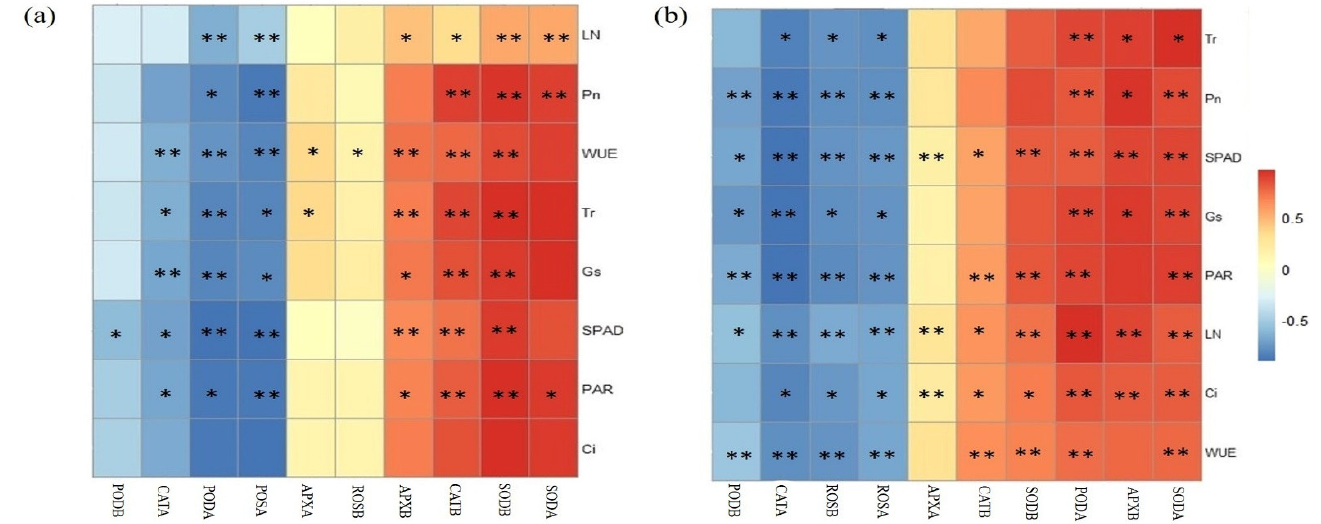
Figure 3. Heatmaps of the photosynthetic parameters and antioxidant enzymes of the rice crop: ( a ) 50th and ( b ) 80th days after transplanting. Asterisks indicate a highly significant (**) or significant (*) interaction between the different parameters. Pn = net photosynthetic rate; Tr = transpiration rate; Gs = stomatal conductance; PAR = photosynthetically active radiation; Ci = intracellular CO 2 con- centration; WUE = water-use efficiency; Leaf N = leaf nitrogen; APXB = ascorbate peroxidase in be- lowground; APXA = ascorbate peroxidase in aboveground; CATB = catalase in belowground; CATA = catalase in aboveground; PODB = peroxidase in belowground; PODA = peroxidase in above- ground; SODB = superoxide dismutase in belowground; SODA = superoxide dismutase in above- ground; ROSB = reactive oxygen species in belowground; ROSA = reactive oxygen species in above- ground. 4. Discussion Understanding the effects of alien plant invasion and residual soil MPs on agricul- tural crop exploration and implementation is essential in agricultural frameworks. Thus, the adverse impact of invasive alien plant and/or soil MPs contamination in food webs pose high risks to human health and safety. 4.1. Effects of S. canadensis Invasion and Residual Soil MPs on Rice Biomass and Phenology Our results suggested that both the individual and interactive effect of S. canadensis invasion and residual soil MPs significantly negatively affected the biomass of rice (Tables 1 and 2, Tables S1 and S2). In particular, S. canadensis invasion caused the least reduction in rice biomass and phenological indices, while the combined effect of S. canadensis inva- sion and residual soil MPs caused the most considerable decrease compared to control treatments. These findings confirmed our first and second hypotheses. S. canadensis invasion is documented as an ecological threat to crops and a few studies have demonstrated its impacts on crops; this may be due to the presence and release of toxic materials that induced minor changes in the soil physicochemical quality, but had higher interactive effects on crops [42,50,51]. These minor changes are interrelated to toxic materials present in the soil, which also induced a significant change in the application of various models related to plants in the soil [51]. Similarly, S. canadensis affects crops by changing the soil physicochemical properties due to higher secretion of allelochemicals from the roots and alternatively had negative effects on the crop’s biomass and phenolog- ical indices [52]. Moreover, MPs in the soil also have a significant influence on various crops’ biomass as they disturb the soil microenvironment and fertility and thus induce changes in the physiological activities of crops [13,20,28,29,31]. Although the interactions of S. canadensis invasion and residual soil MPs were previously unknown, this study